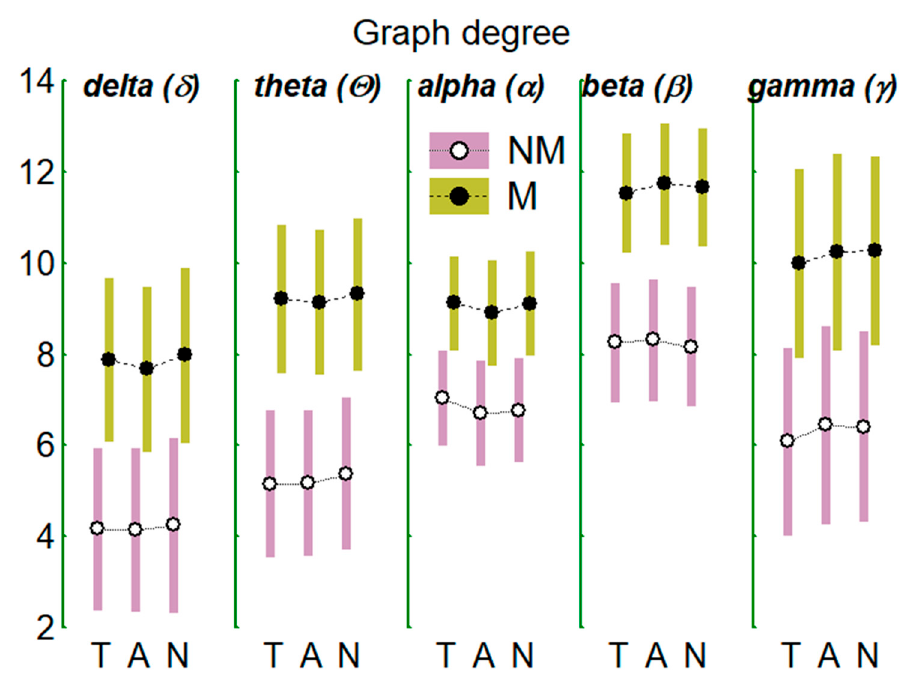
Figure 5. Mean values ( ± 95% confidence interval) for the degree of EEG graph/network in the two groups of subjects (NM and M) in the 5 indicated EEG frequency bands and in the 3 auditions considered (T: tonal, A: atonal, and N: noise). Table 1. MANOVA results for the EEG graph indices, degree, density, and strength. In the first column, the factors indicated were: (MNM for comparisons between musician (M) vs non-musicians (NM) groups, FB for repeated comparisons between frequency bands, TAN for those corresponding to the different auditions [tonal (T), atonal (A) and noise (N)], and FB * TAN for cross-interactions; in successive columns, appear the test used (W-R or L-B); the F statistic, the degrees of freedom (DF), and the level of significance P; in the last column (Comp.) with asterisks * the significance levels of the a posteriori comparisons between pairs of repeated factors are indicated (** for p < 0.01, and *** for p <